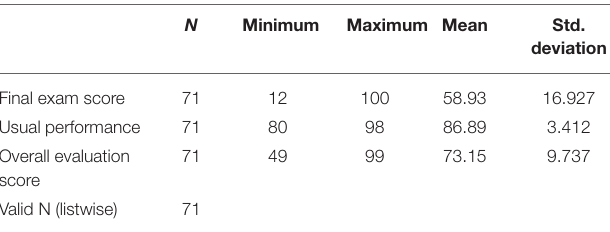
TABLE 1 | Descriptive statistics of teacher-oriented graduates majoring in